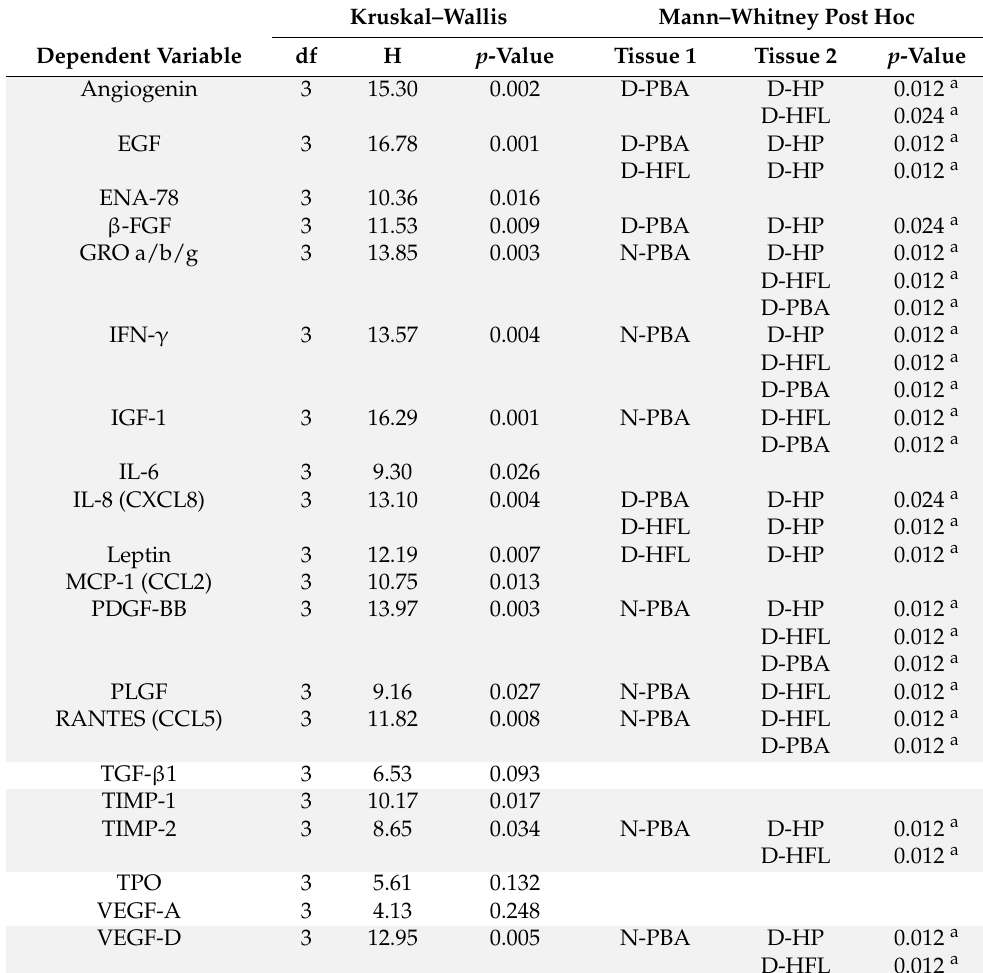
Table 2. Comparison of angiogenic growth factor contents between each different